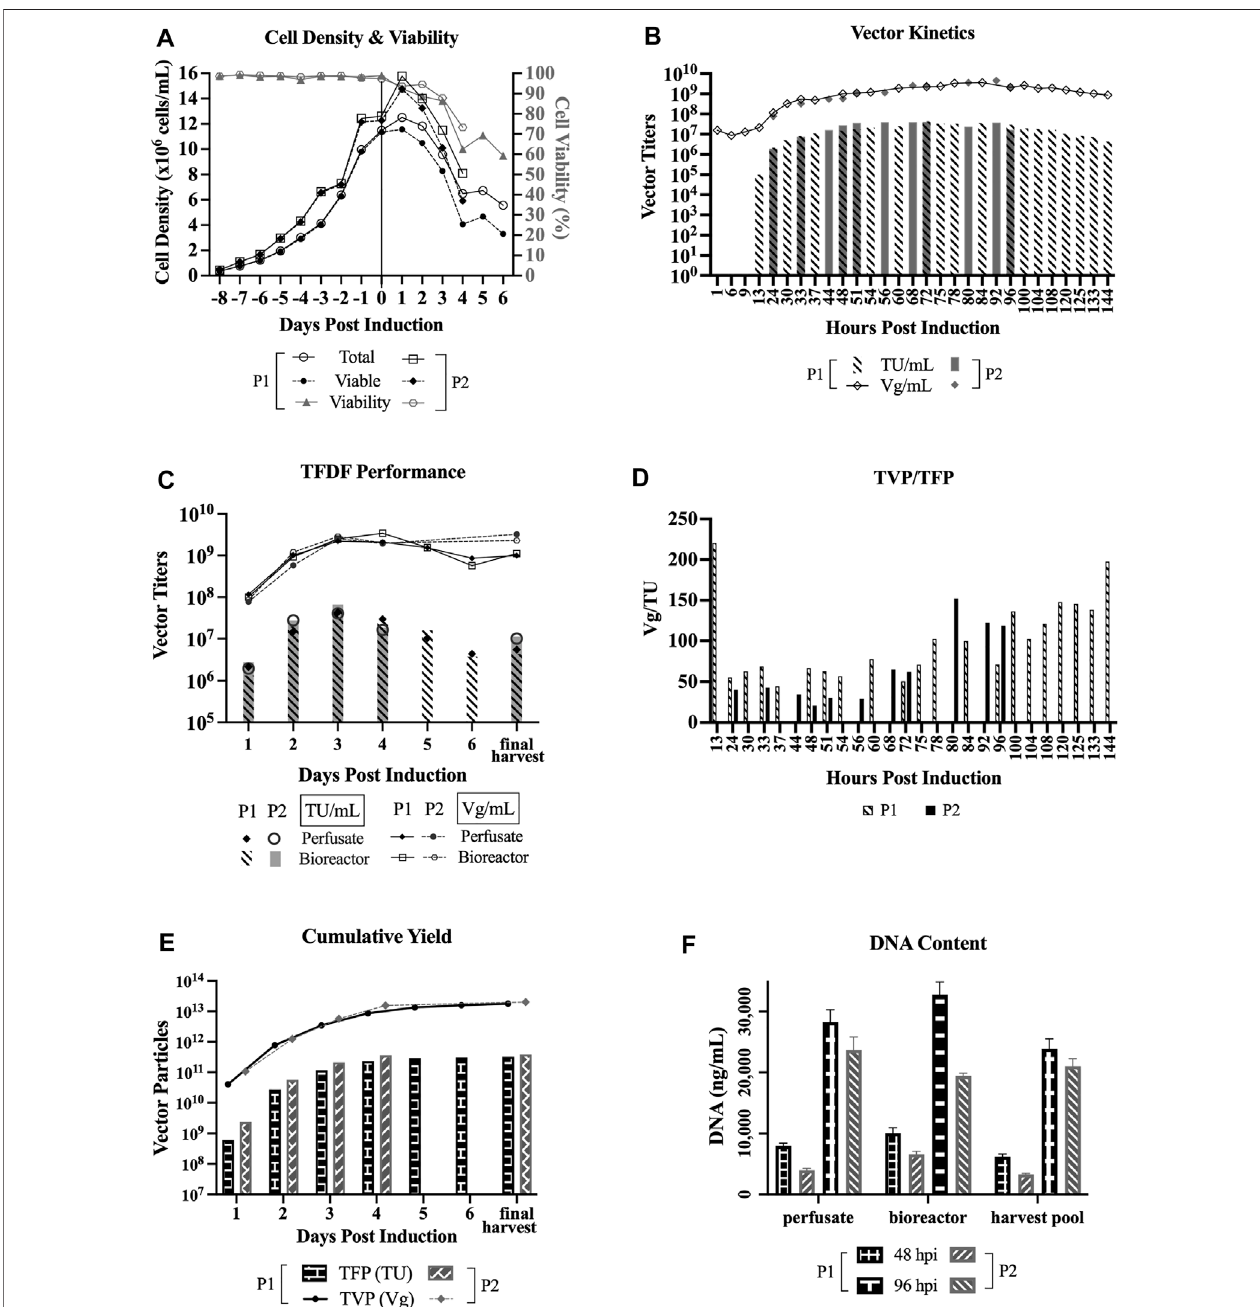
FIGURE 2 | LV production in perfusion mode using TFDF. TFDF = Tangential Flow Depth Filtration; P1 = perfusion run 1; P2 = perfusion run 2; TU = transducing units; Vg = vector genome; TFP = total functional particles; TVP = total vector particles. “ Final harvest ” refers to the material recovered from the fi nal harvest step (i.e., concentration,dia fi ltration, fi nalconcentration)inP1andtheleftoevermaterialinthebioreactorinP2attheendoftheperfusionruns. (A) Celldensityandcellviabilitydata of perfusion runs ( n = 2). (B) LV production kinetics in TU/mL and Vg/mL (some common and some different time points sampled between P1 and P2). (C) Perfusate and bioreactor samples in TU/mL and Vg/mL to assess whether the virus is retained by the TFDF device. (D) Ratio of TVP to TFP (some common and some differenttimepointssampledbetweenP1andP2). (E) CumulativevectoryieldsforP1(3.2×10 11 TFP,1.8×10 13 TVP)over6 daysandforP2(3.9×10 11 TFP,2.0×10 13 TVP) over 4 days. (F) DNA content at an early time point (48hpi) and late time point (96hpi) of the perfusion runs (values are shown as mean +SD and refer to serial dilutions of the samples on the assay plate).